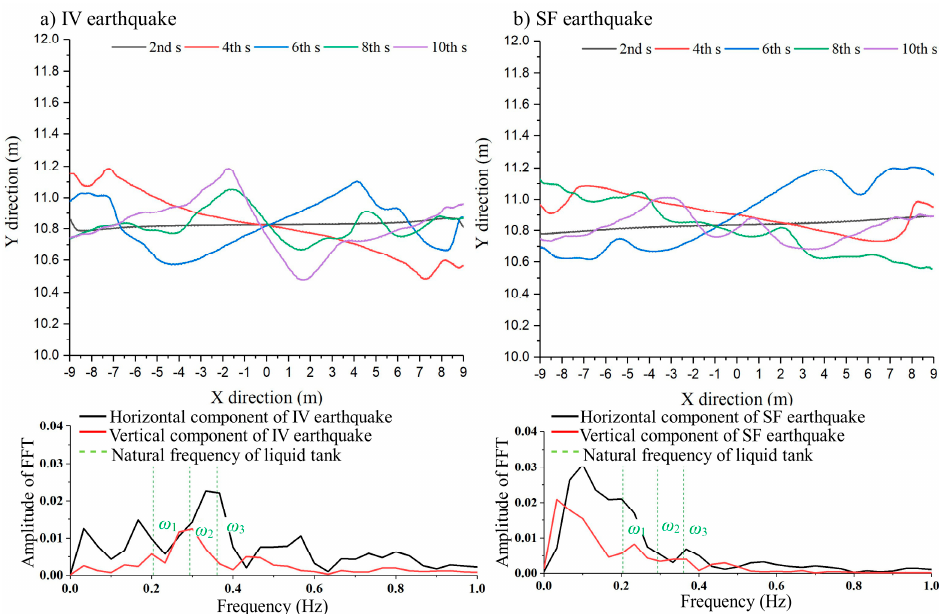
Figure 10. Free surface response at selected moments, ( a ) the free surface response under the Imperial Valley 1940 earthquake, ( b ) the free surface response under the San Fernando 1971